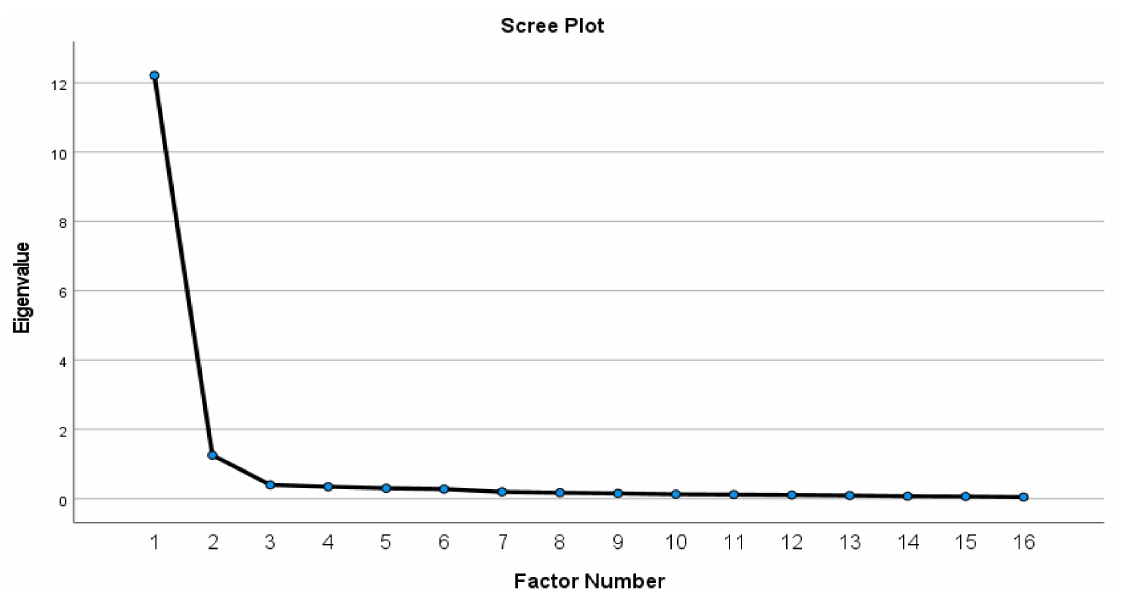
Figure 3. Scree plot for construction health and safety agent collaboration and health and safety performance factor